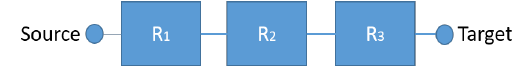
Figure 5. RBD organized in series.